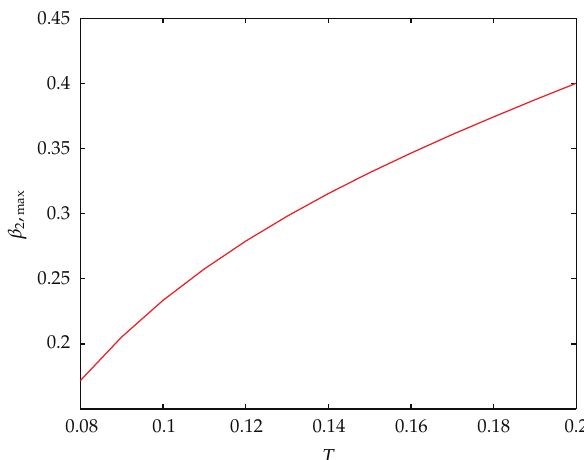
Figure 7: β 2 , max versus T for the class of systems given in Example